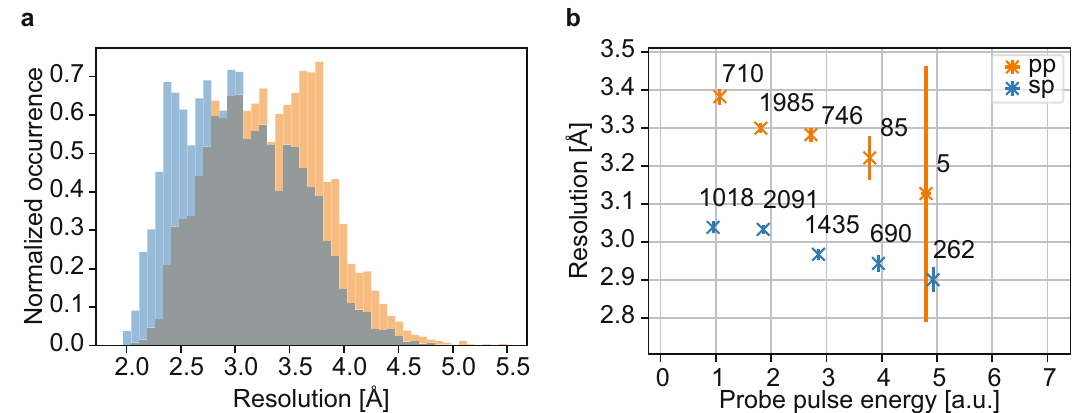
Fig. 3 Resolution of the single-pulse and pump – probe SFX data. a Normalized histogram of the resolution of all indexed hits of the pump – probe (orange) and single-pulse reference (blue) data set. The median resolution of all indexed hits is 3.3 Å in the pump – probe case and 3.0 Å for the single-pulse reference data. b Diffraction resolution of the pump – probe (orange) and the single-pulse (blue) data set as a function of probe pulse energy. Indexed haemoglobin diffraction patterns were binned according to the probe pulse energy measured by the X-ray sensitive photo diode masked with an Fe foil of same thickness as the Fe fi lter in front of the CSPAD detector. The median resolution of all indexed diffraction images contained in one probe pulse energy bin is plotted. The error bars correspond to the error of the mean per bin. The number next to each data point indicates the number of indexed diffraction patterns within a given bin. For all probe pulse energies, the resolution of the pump – probe data is consistently lower than the resolution of the single-pulse reference data, indicating that the observed effect is not caused by a difference in changing probe pulse energy conditions between the two data sets (Supplementary Fig. 4). Equalization of probe pulse energy distributions (Supplementary Methods) between the two data sets leads to the same conclusion (Supplementary Fig. 5). The resolution limit ( a , b ) corresponds to the highest resolution value of an indexed diffraction peak with a signal-to- noise ratio of I / σ ( I ) ≥